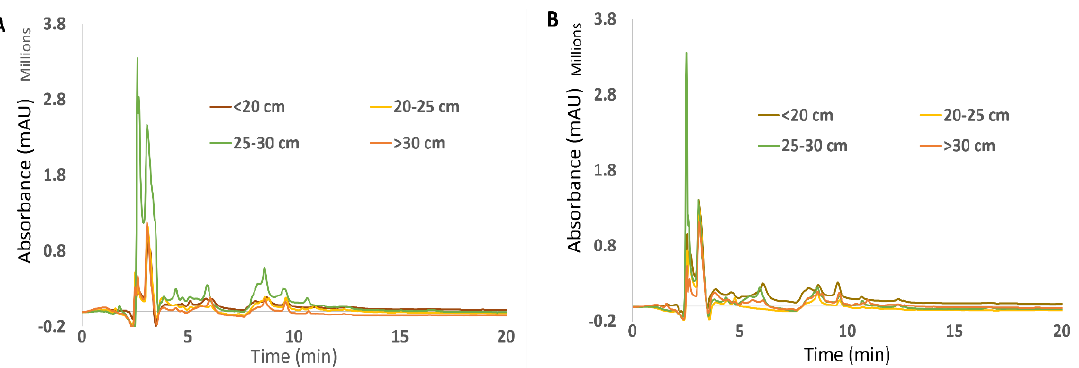
Figure 5. HPLC-DAD chromatographic profile of ( A ) male and ( B ) female samples of F. vesiculosus , extracted at 25 °C (1 mg/mL), across four growth stages—(-) <20 cm, (-) 20–25 cm, (-) 25–30 cm and (-) >30 cm. The y-axis was adjusted according to each respective maximum peak (3,800,000 for both chromatograph).